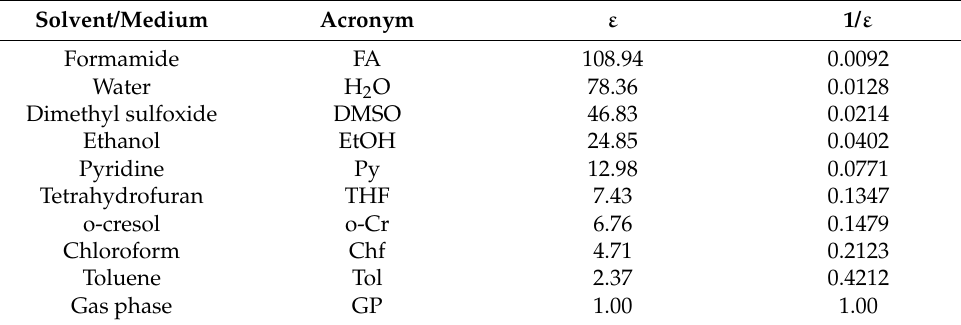
Table 1. Values of dielectric constants ( ε ) of studied solvents.